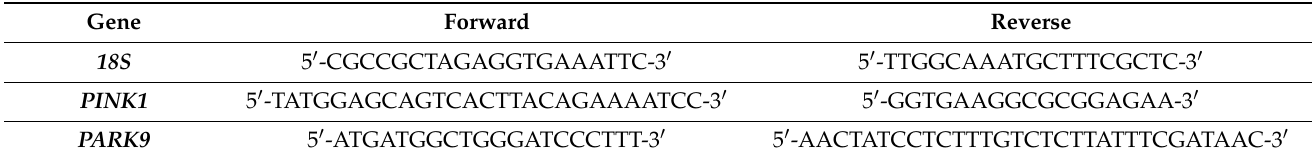
Table 2. List of primers used in RT-qPCR experiments.